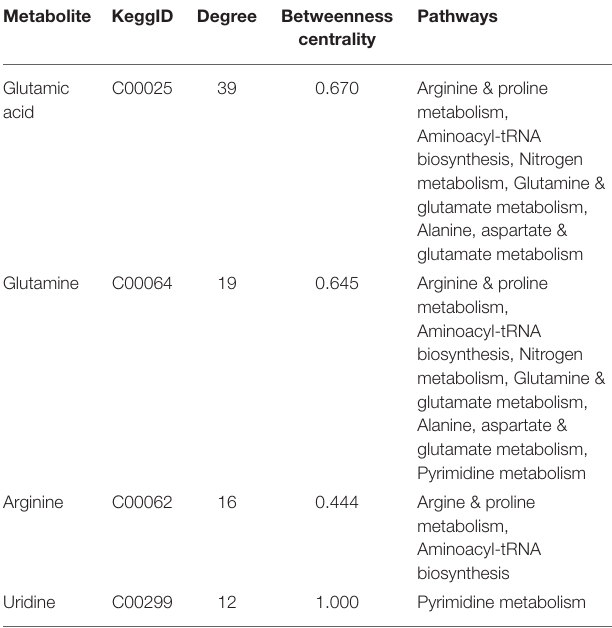
TABLE 3 | Topological parameters of key metabolites. Metabolite KeggID Degree Betweenness